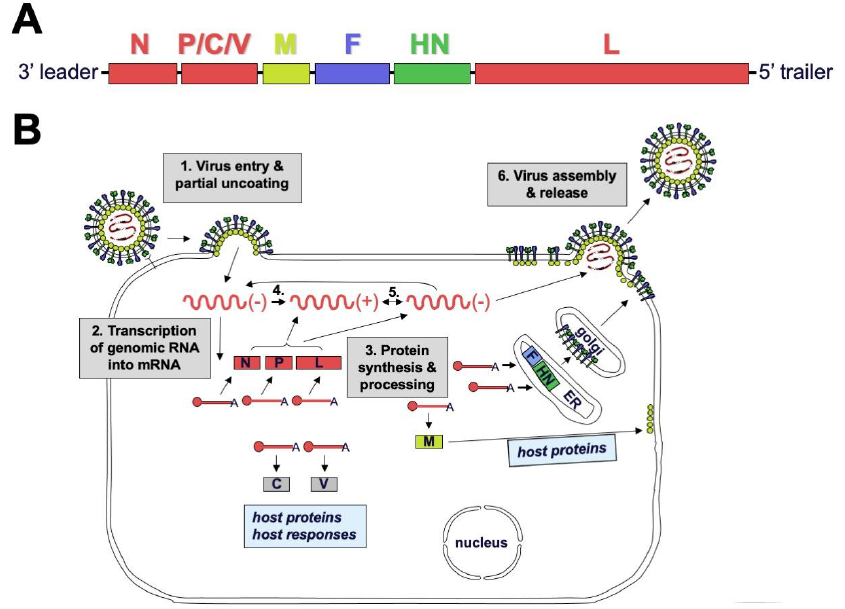
Figure 2. SeV replication cycle. ( A ) Genome structure of SeV. Polymerase complex genes nucle- ocapsid (N), phosphoprotein (P), and large polymerase (L) are color-coded red; matrix (M) is col- ored yellow; fusion (F) is colored blue; and hemagglutinin-neuraminidase (HN) is colored